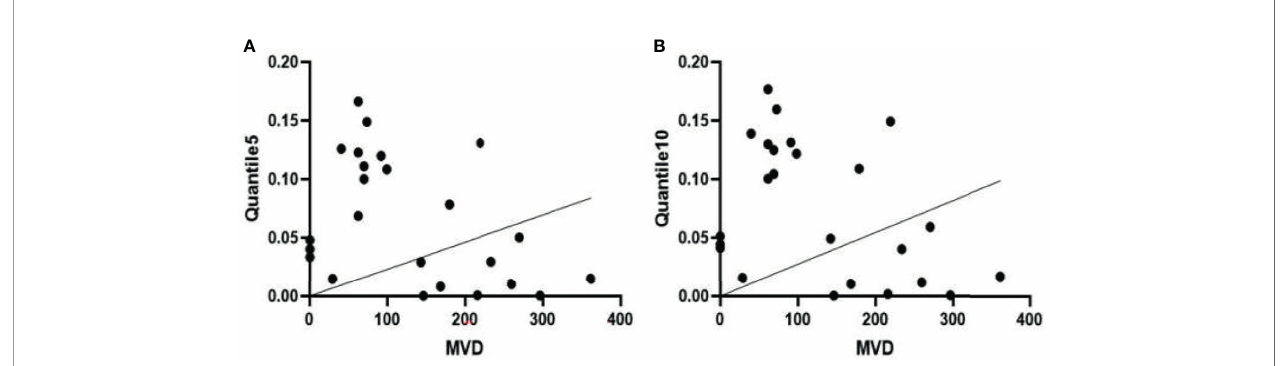
FIGURE 8 | (A) There is a negative correlation between microvascular density (MVD) and the Quantile5 texture parameter in the femoris lateralis muscle of experimental group rabbits at week 3 after successful creation of a critical limb ischaemia model. (B) MVD is also negatively correlated with the texture parameter Quantile10.